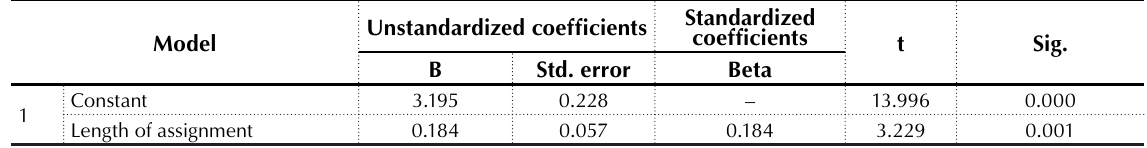
Table 5. Impact of length of assignment on acclimatization of expatriates